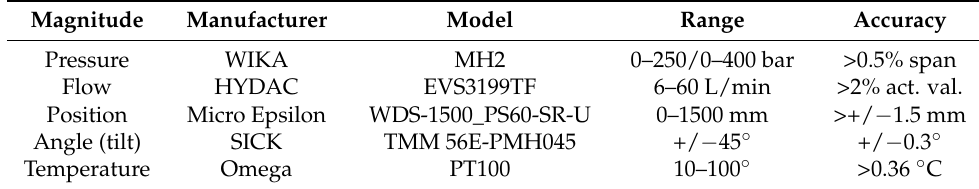
Table 3. List of main characteristics of used sensors.